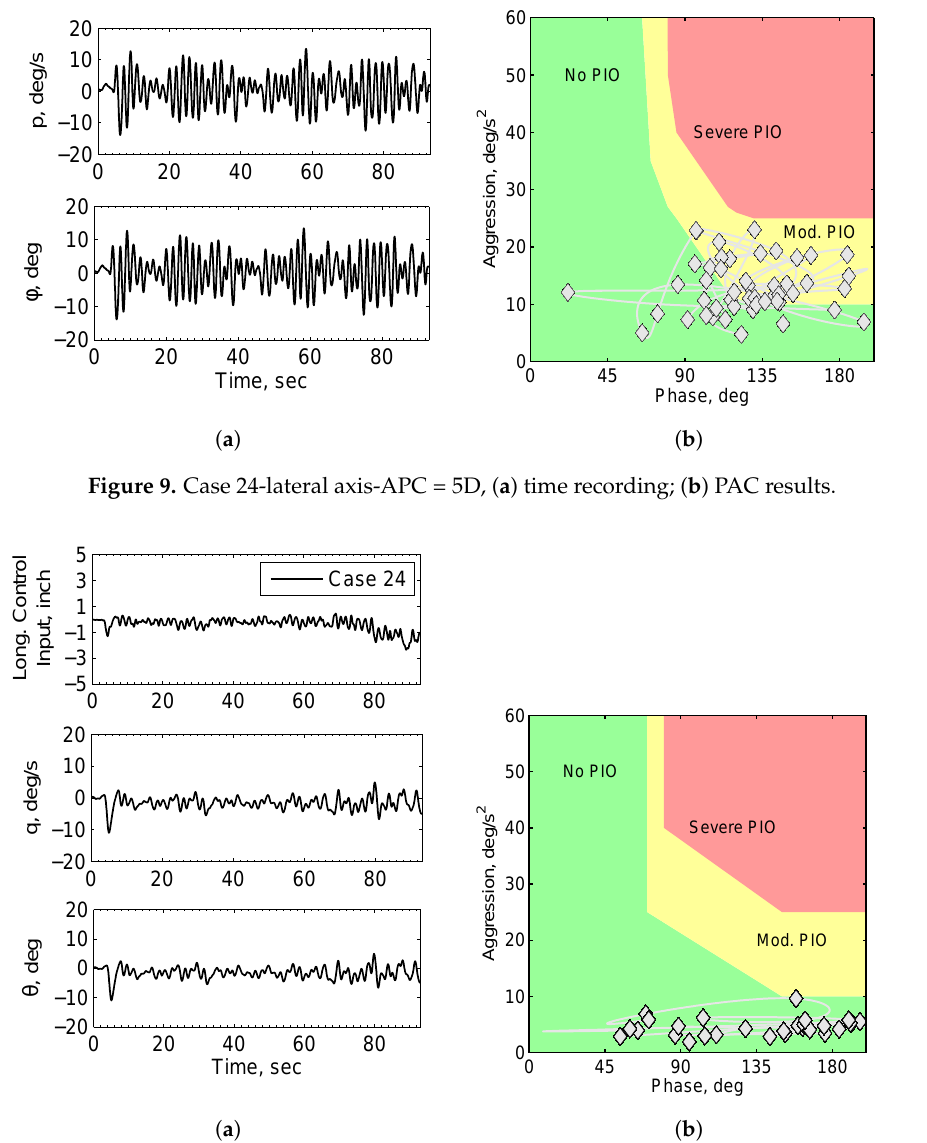
Figure 10. Case 24-longitudinal axis, ( a ) time recording; ( b ) PAC